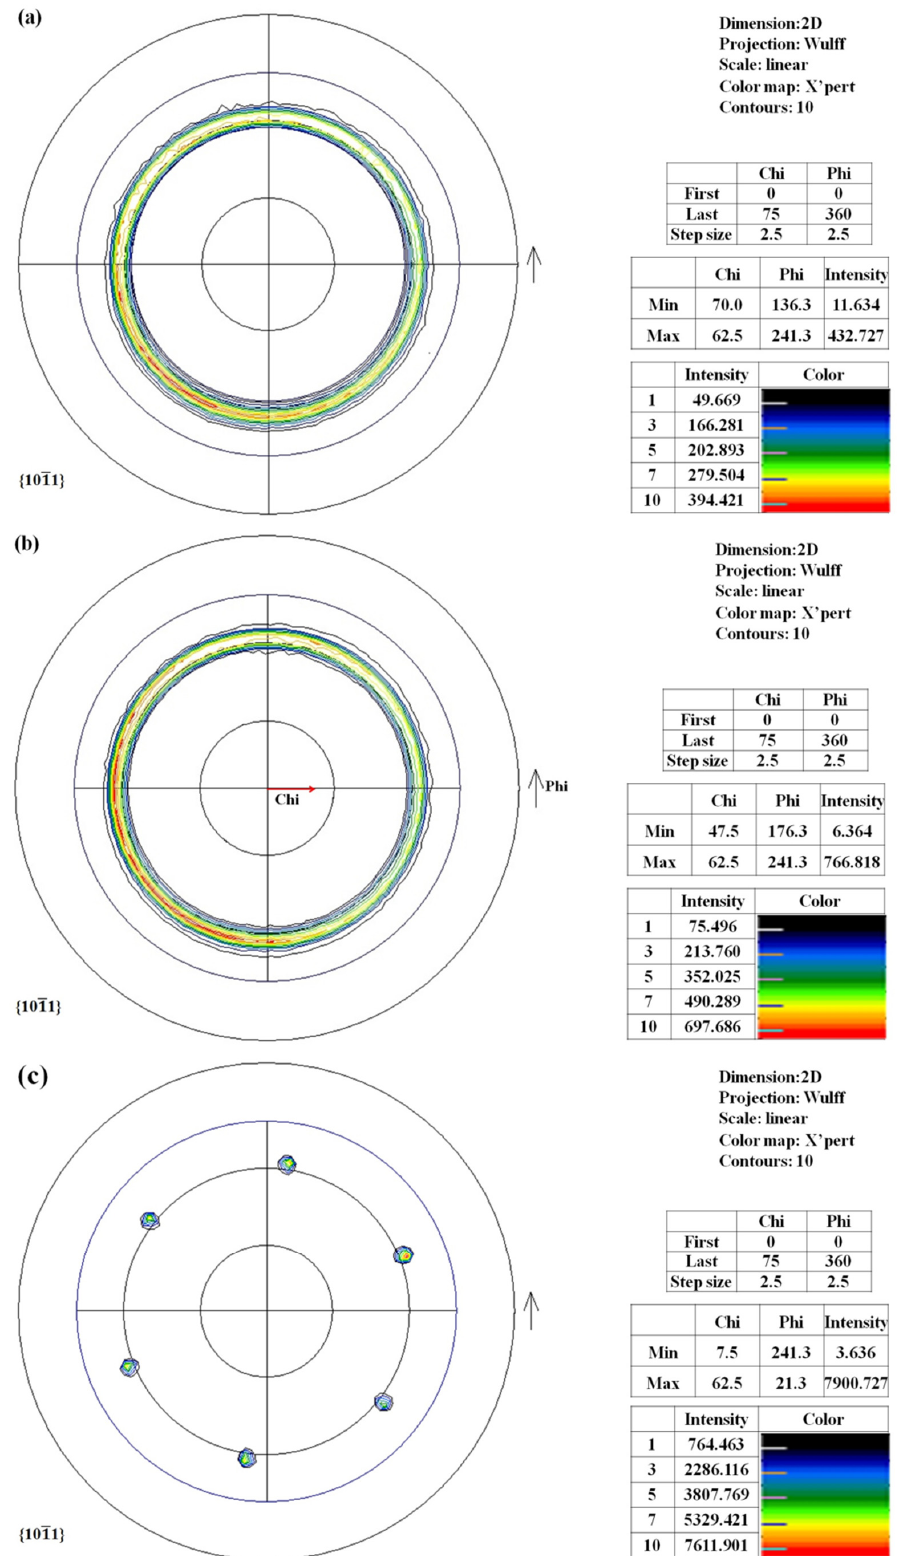
Figure 3. {10 1(cid:3364) 1} pole figures (2 θ = 37.89°) of ( a ) hexagonal AlN/Si(100) ( b ) hexagonal AlN/Si Figure 3. {1011} pole figures (2 θ = 37.89 ◦ ) of ( a ) hexagonal AlN/Si(100) ( b ) hexagonal AlN/Si(111)and (111)and ( c ) of h-AlN/AlN MBE (1 nm)/Si(111). ( c ) of h-AlN/AlN MBE (1